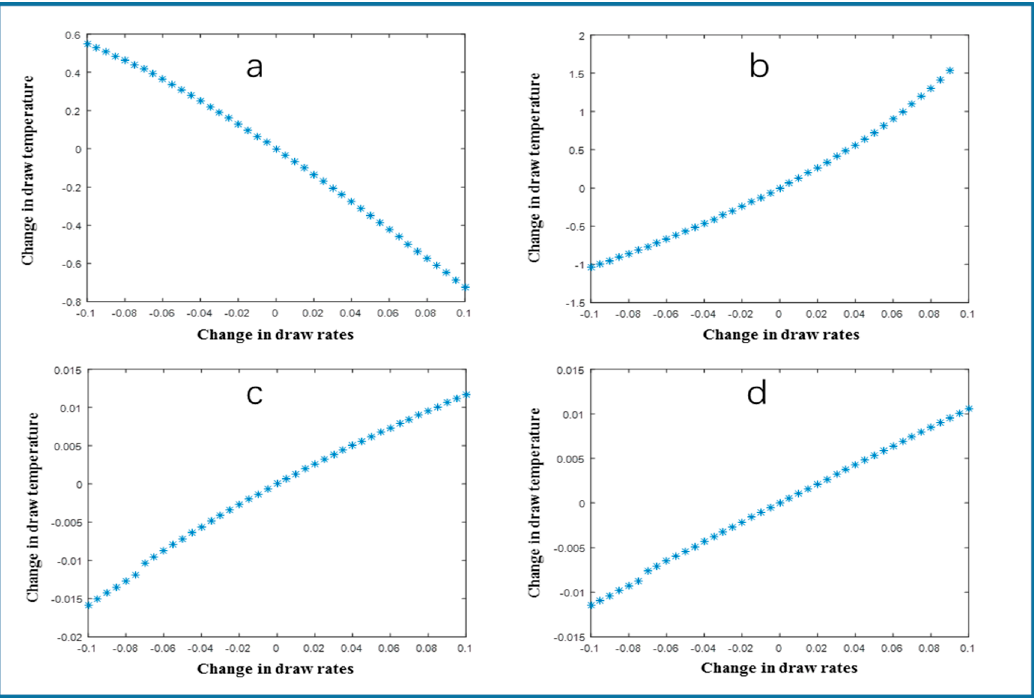
Figure 10. Sensitivity results of the side draw rate and ASTM D86 curve change of different products and methods: ( a ) naphtha with the HCRSRK method; ( b ) naphtha with the data-based delumping method; ( c ) diesel with the HCRSRK method; ( d ) diesel with the data-based delumping method.